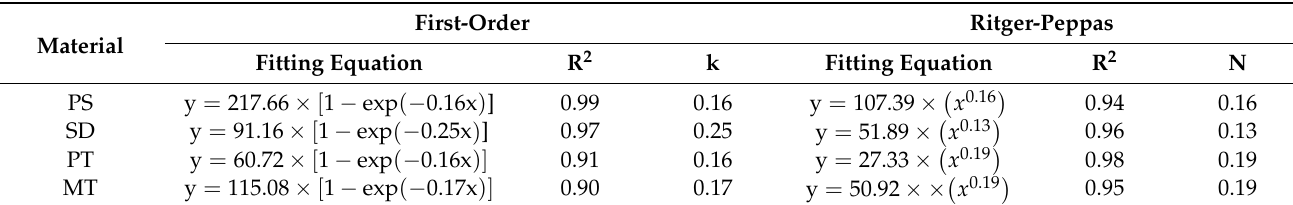
Table 4. Kinetic fitting of the carbon release process from different carbon sources. First-Order Ritger-Peppas Material Fitting